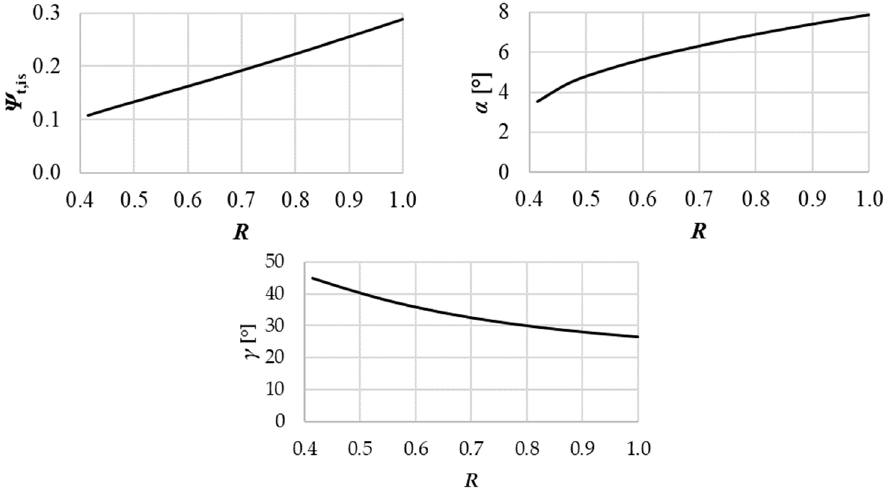
Figure 10. Calculated distributions ψ t,is ( R ), α ( R ), and γ ( R ) as a function of R .